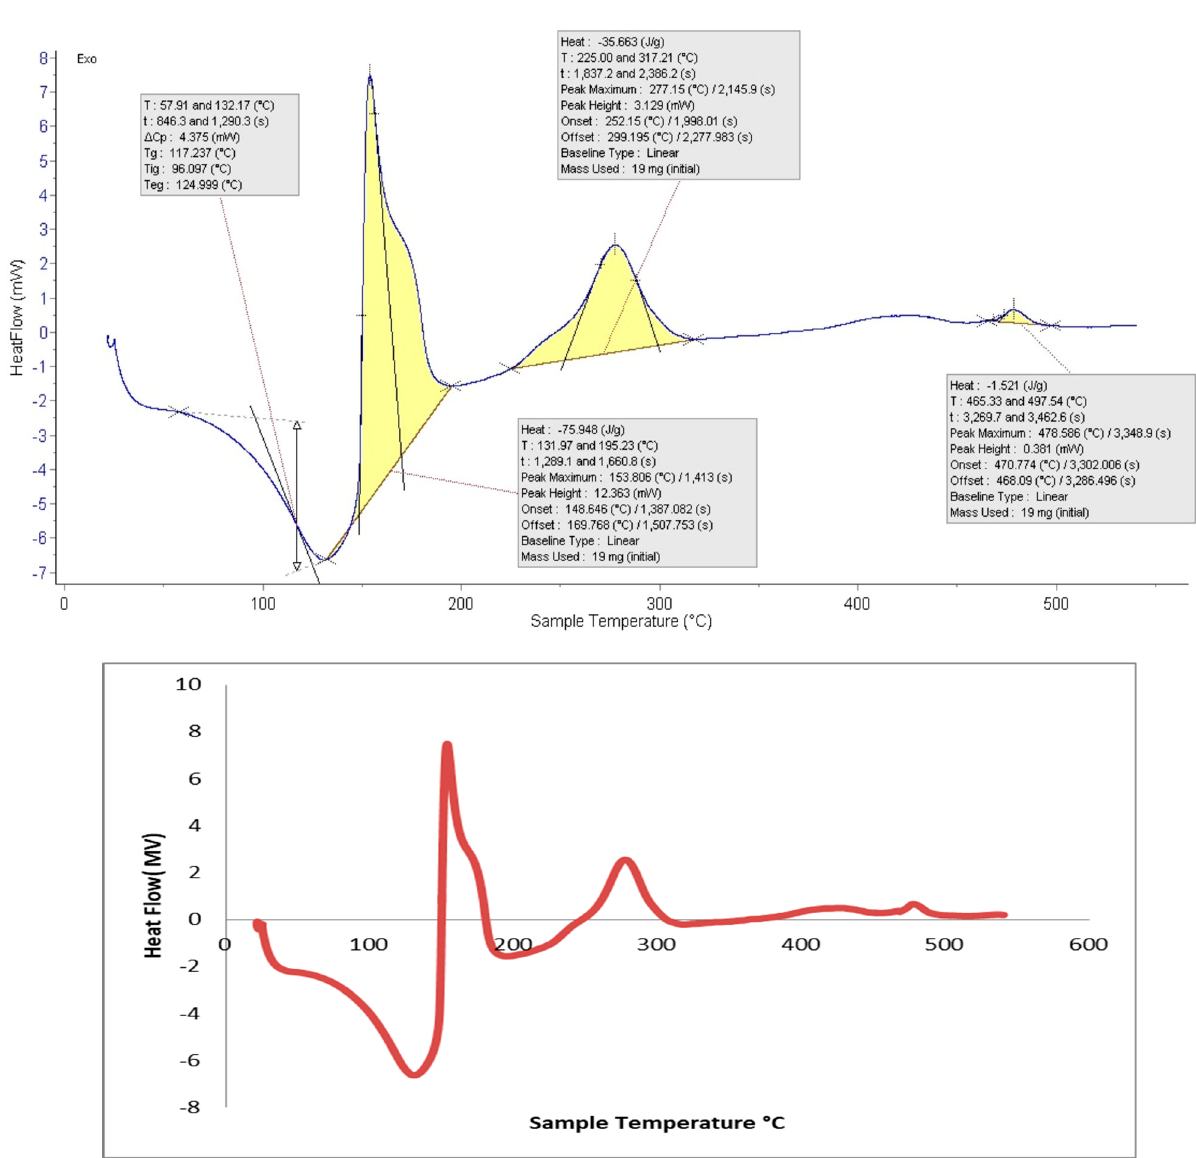
Figure 8. DSC of Ulva/Ag/cellulose nanocomposite blend with fluoride.